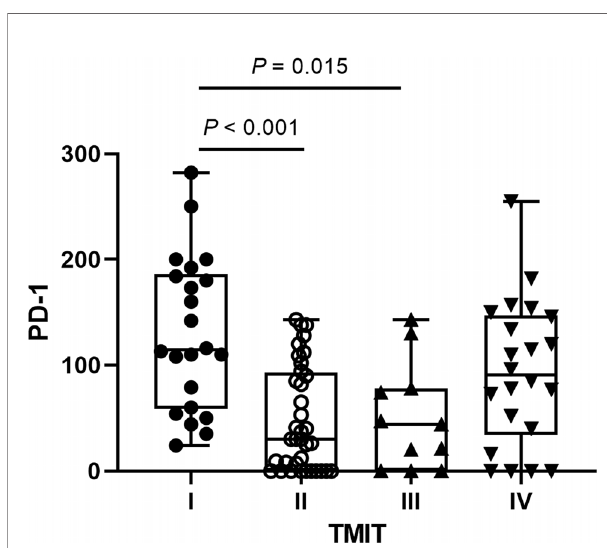
FIGURE 1 | The distributions of programmed cell death 1 (PD ‐ 1) expression according to different tumor microenvironment immune types (TMITs). The PD-1 expression was signi fi cantly higher in TMIT I tumors than TMIT II and III